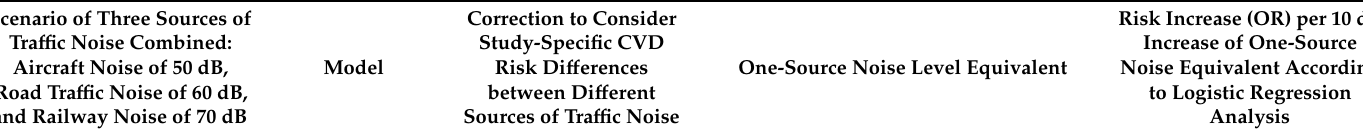
Scenario of Three Sources of Tra ffi c Noise Combined: Aircraft Noise of 50 dB, Road Tra ffi c Noise of 60